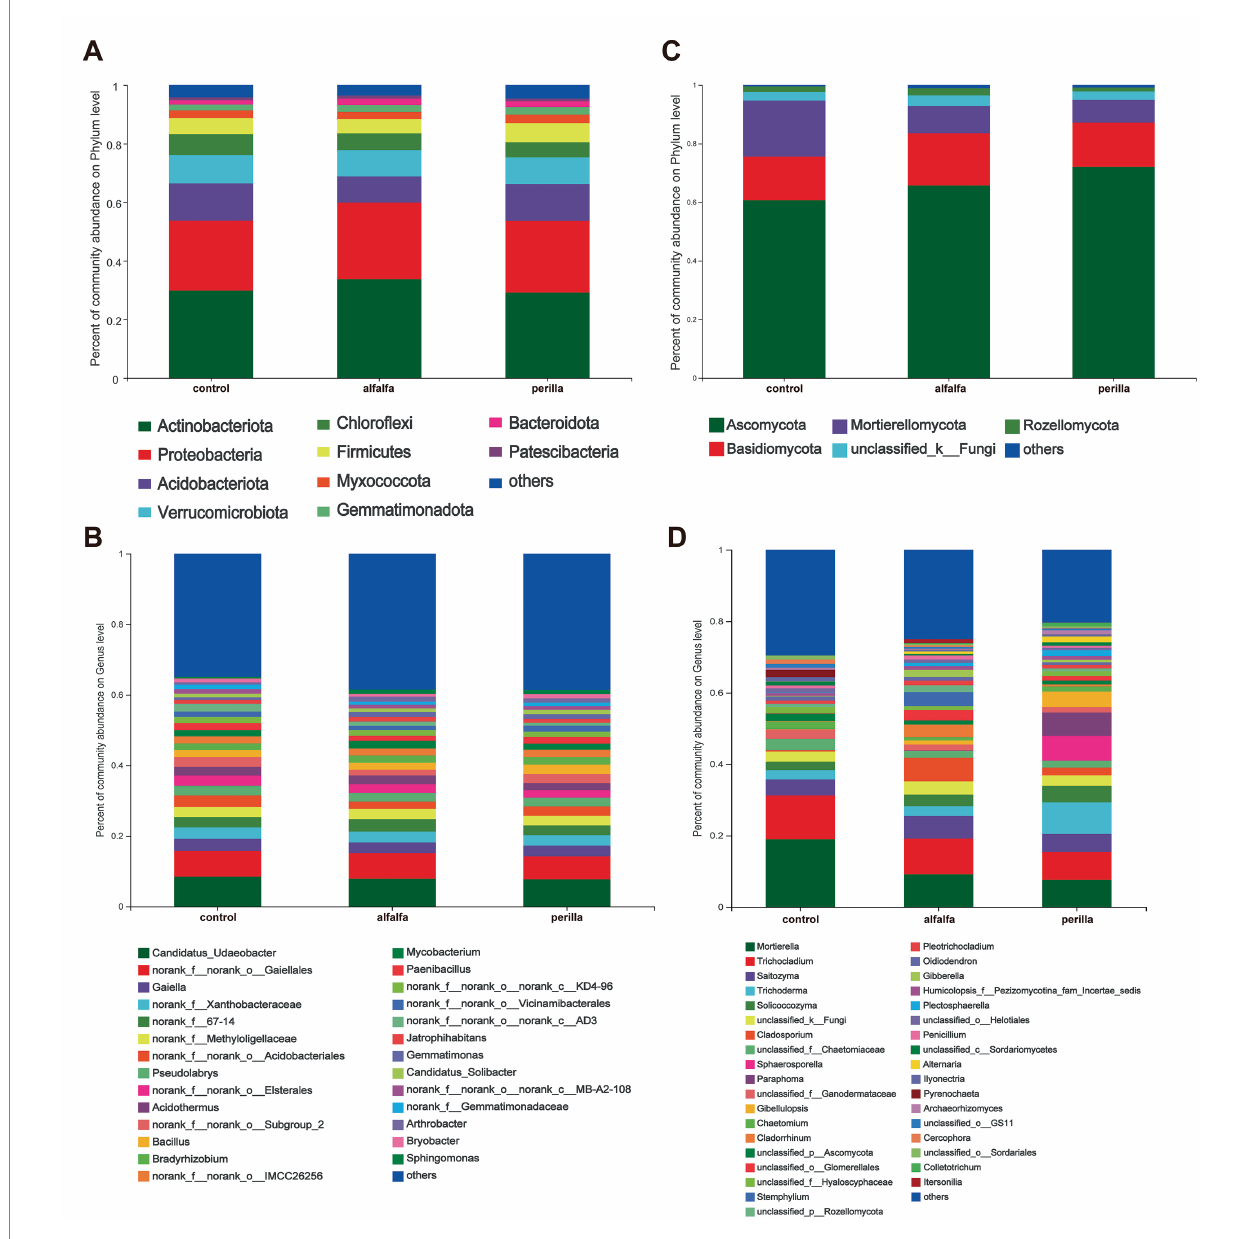
FIGURE 4 Relative abundances of (A) bacterial and (B) fungal phylum level and (C) bacterial and (D) fungal genus level in different treatments. Control, no treatment; Alfalfa, alfalfa cultivation; Perilla, perilla